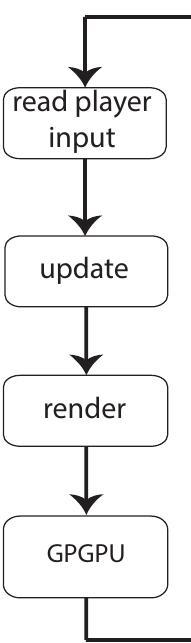
Figure 7. Simple Coupled Model with an GPGPU stage.